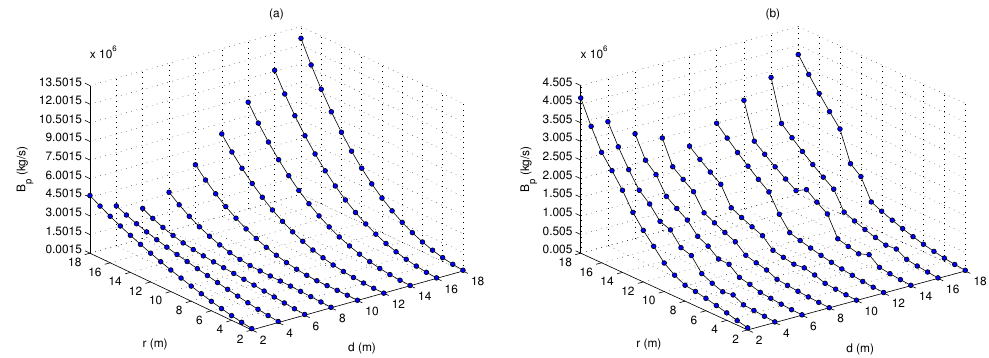
Figure 3. PTO damping coefficients when k C = 0.75 for ( a ) passive control (PC) and ( b ) LC.